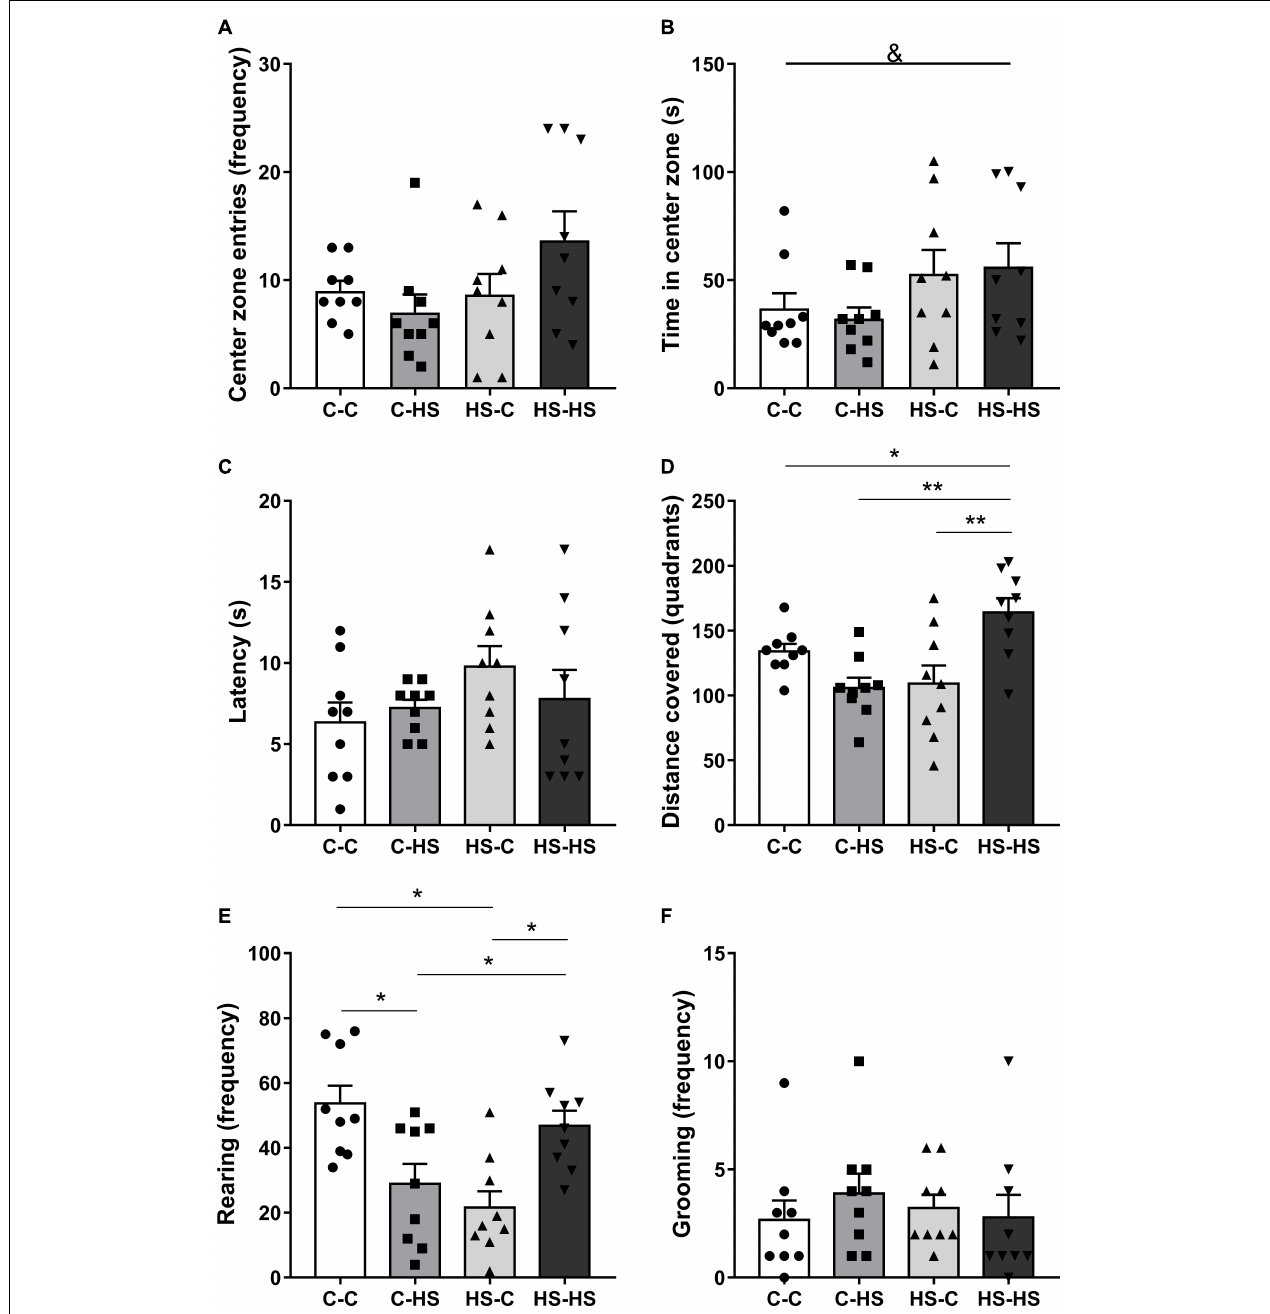
FIGURE 3 | Entries frequency (A) , time spent at the central zone (B) , latency to leave the center zone (C) , distance covered (D) , rearing (E) , and grooming frequency (F) in the open field test. C-C, offspring of standard diet fed dams who received a standard diet after weaning; C-HS, offspring of standard diet fed dams who received a HS diet after weaning; HS-C, offspring of HS diet fed dams who received a standard diet after weaning; and HS-HS, offspring of HS diet fed dams who received a HS diet after weaning. Data are shown as mean and SEM; n = 9. & p < 0.05 (preweaning factor); * p < 0.05, ** p < 0.01 (interaction of the pre- and postweaning factors) using the ANOVA and the Newman–Keuls